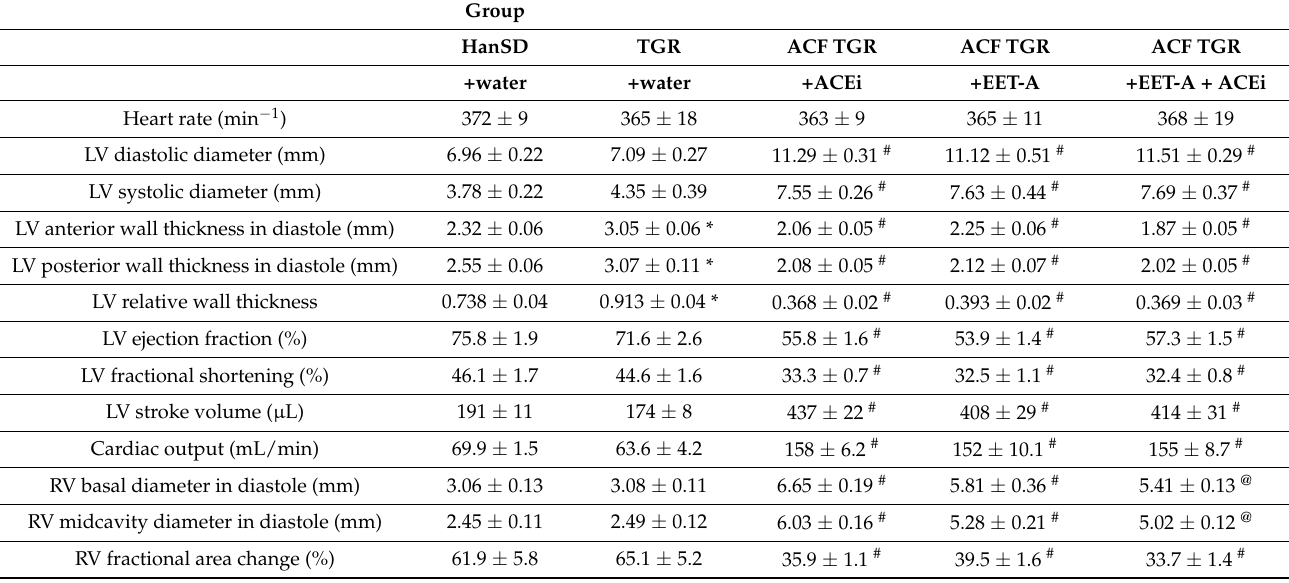
Table 5. Echocardiographic analysis 22 weeks after the induction of aorto-caval fistula (ACF) or sham-operation and after 20 weeks ´ treatment with 14,15-epoxyeicosatrienoic acids analog (EET-A) and angiotensin-converting enzyme inhibitor (ACEi) alone or combined with